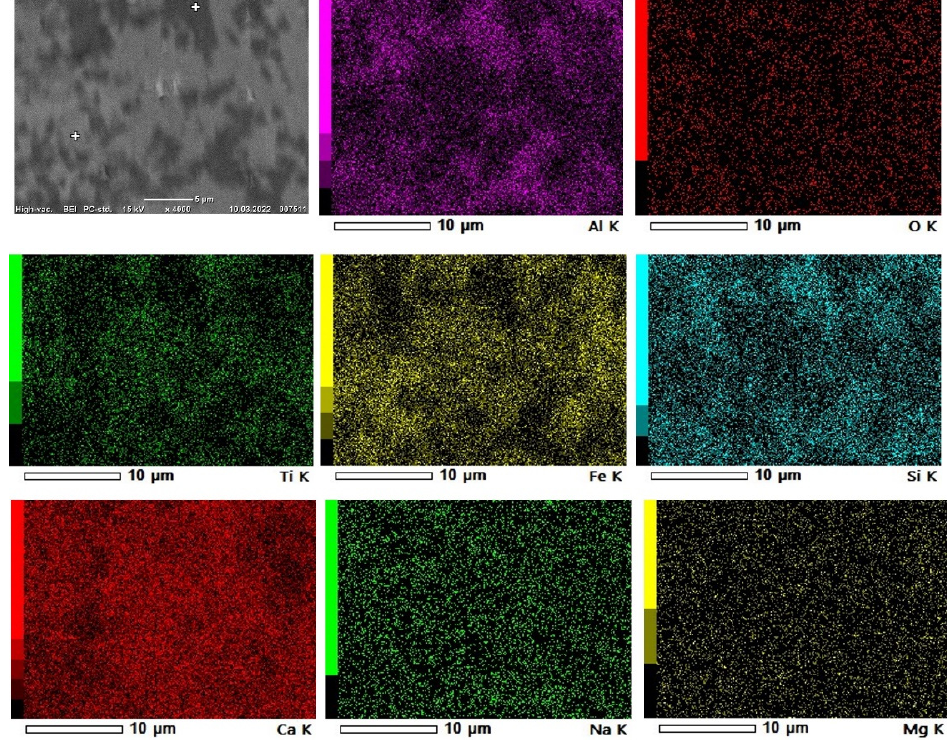
Figure 9. X-ray mapping and BEI of sintered pellet. Brownmillerite (Ca 2 (Al, Fe 3+ ) 2O 5 ) and gehlenite (Ca 2 Al (AlSiO 7 )) represent the main phases, where brownmillerite is the brighter iron-rich phase and gehlenite is the darker phase and contains larger amounts of aluminum (Figure 8). The relative composition of each phase can deviate from the general formula, as different elements can be dissolved